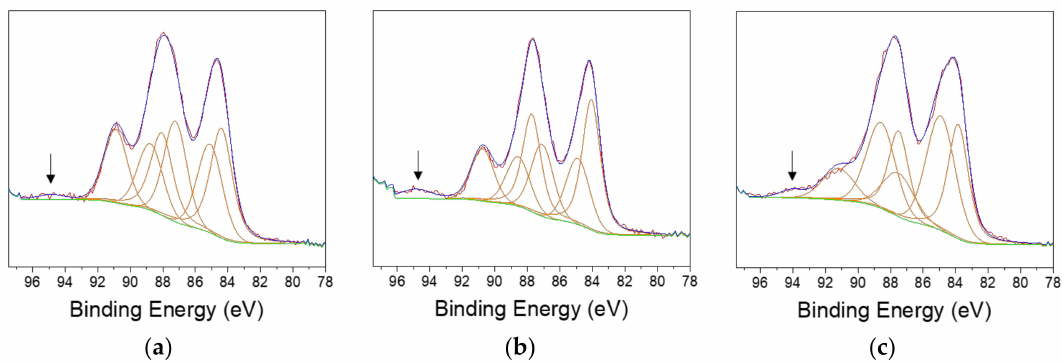
Figure 3. Au4f regions relevant to ( a ) 430-AuNPs, ( b ) 410-AuNPs, ( c ) 304-AuNPs. Arrows indicate the Fe3s component.